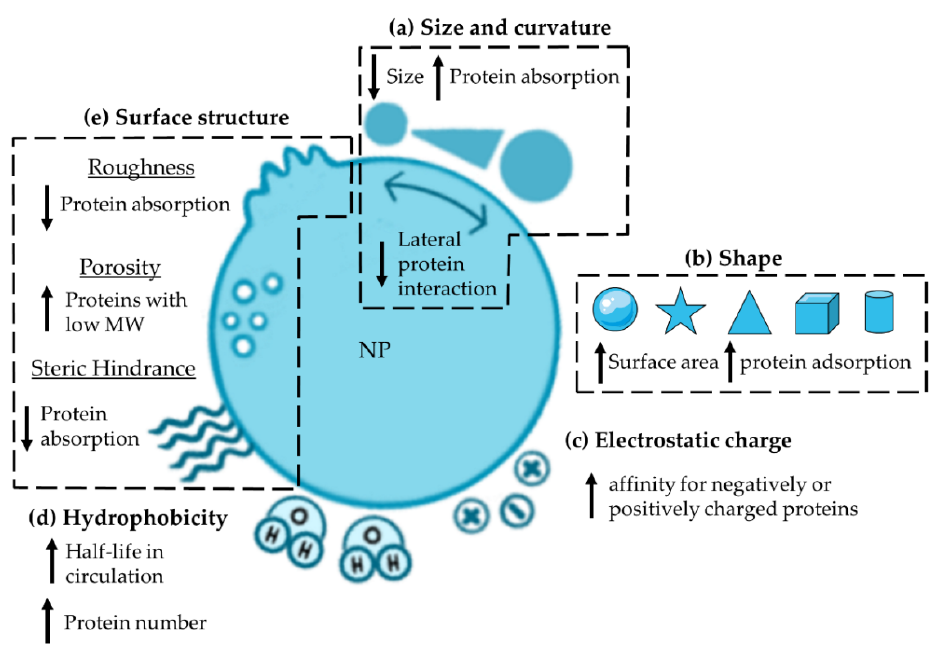
Figure 2. Overview of the intrinsic properties that influence PC formation: ( a ) size and curvature, ( b ) shape, ( c ) electrostatic charge, ( d ) hydrophobicity and ( e ) surface structure. MW: molecular weight; NP: nanoparticle.